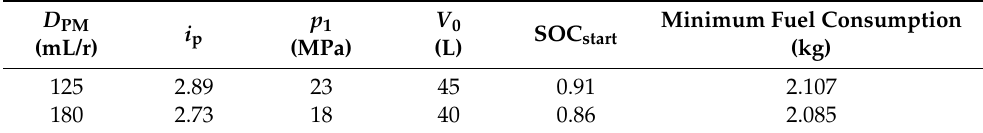
Table 5. Minimum energy consumption of different VDPM displacements.